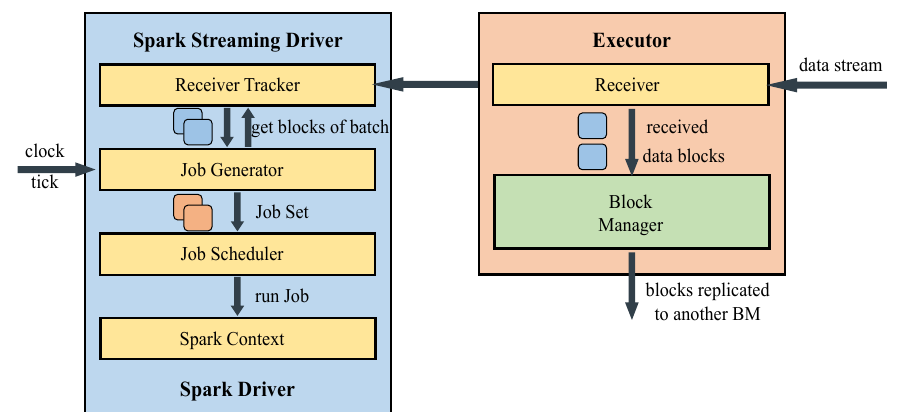
Figure 2. Spark Streaming Architecture Diagram.